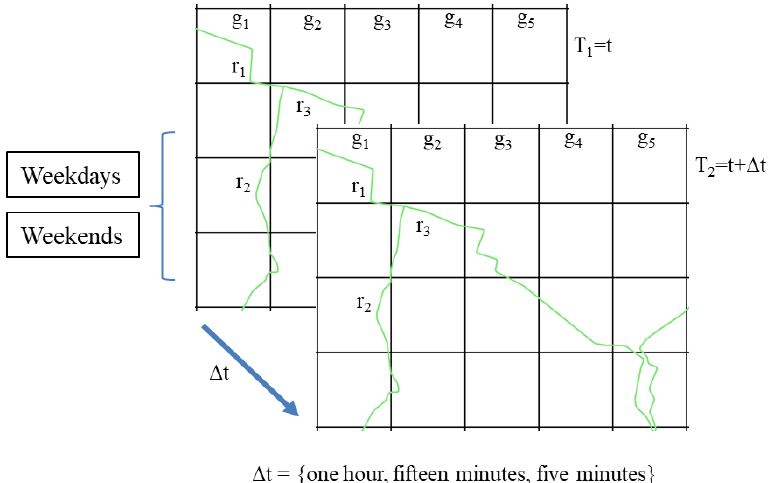
Figure 3. Probe data aggregation in the grid network G for weekday and weekend.